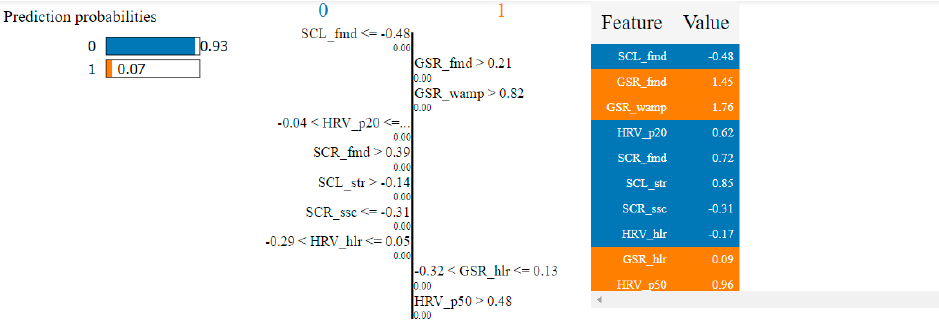
Figure 27. Prediction features for situation 0 (no fear), for the overlapping dataset.